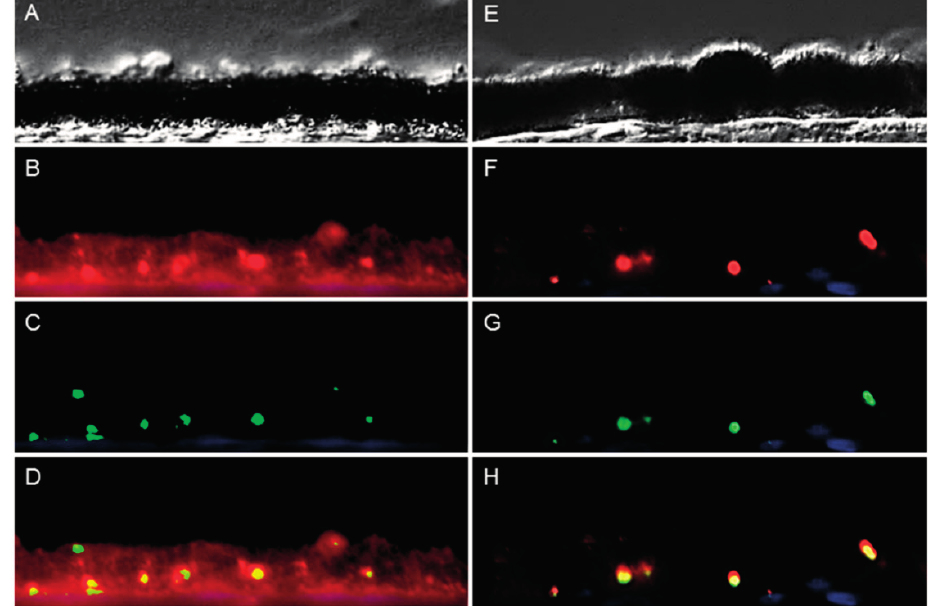
Figure 2. Peripherin 2 (red) and rhodopsin (green) expression in retinal pigment epithelium (RPE) of representative healthy ( left ) and ERU cases ( right ). Differential interference contrast image of healthy ( A ) and diseased ( E ) equine RPE. In healthy ( B ) RPE, peripherin 2 was expressed over the entire RPE cell layer, and the intensity was enhanced in some spots. In uveitic RPE cells ( F ), peripherin 2 was significantly reduced to few small spots; Rhodopsin was limited to few isolated spots, distributed throughout the whole RPE layer, in healthy ( C ), as well as in diseased ( G ) RPE. The overlap of peripherin 2 and rhodopsin in healthy ( D ) RPE indicates significant higher expression of peripherin 2 compared to rhodopsin (the yellow overlap is only displayed in a few spots). In uveitic RPE ( H ), peripherin 2 was only expressed at rhodopsin expression sites (yellow